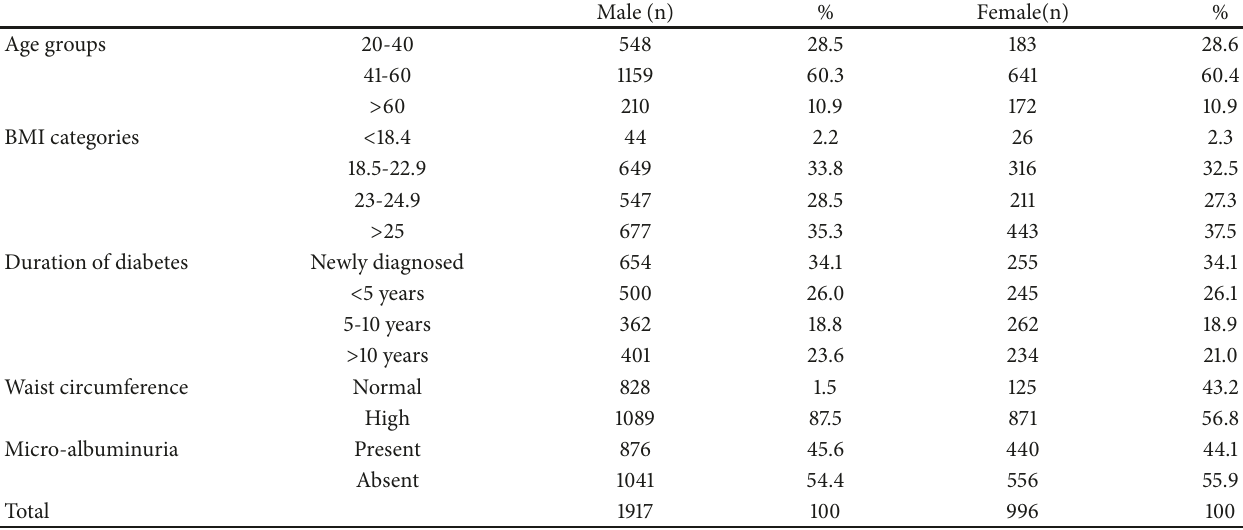
Table 2: Baseline characteristics according to the gender.